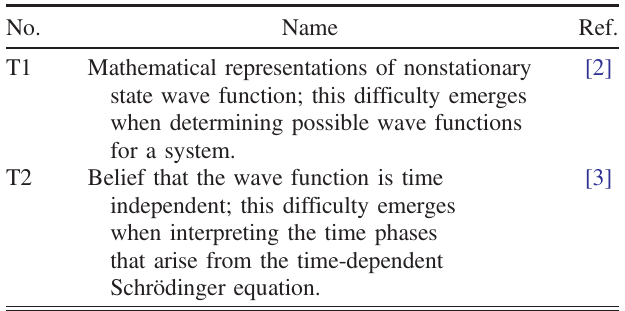
TABLE I. Difficulties that exhibit transition error only. These difficulties are labeled “ T ” for transition errors. The ordering of the difficulties in the table is for labeling purposes only and does not represent a